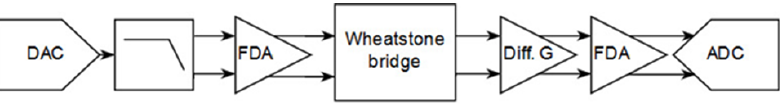
Figure 3. Read-out block